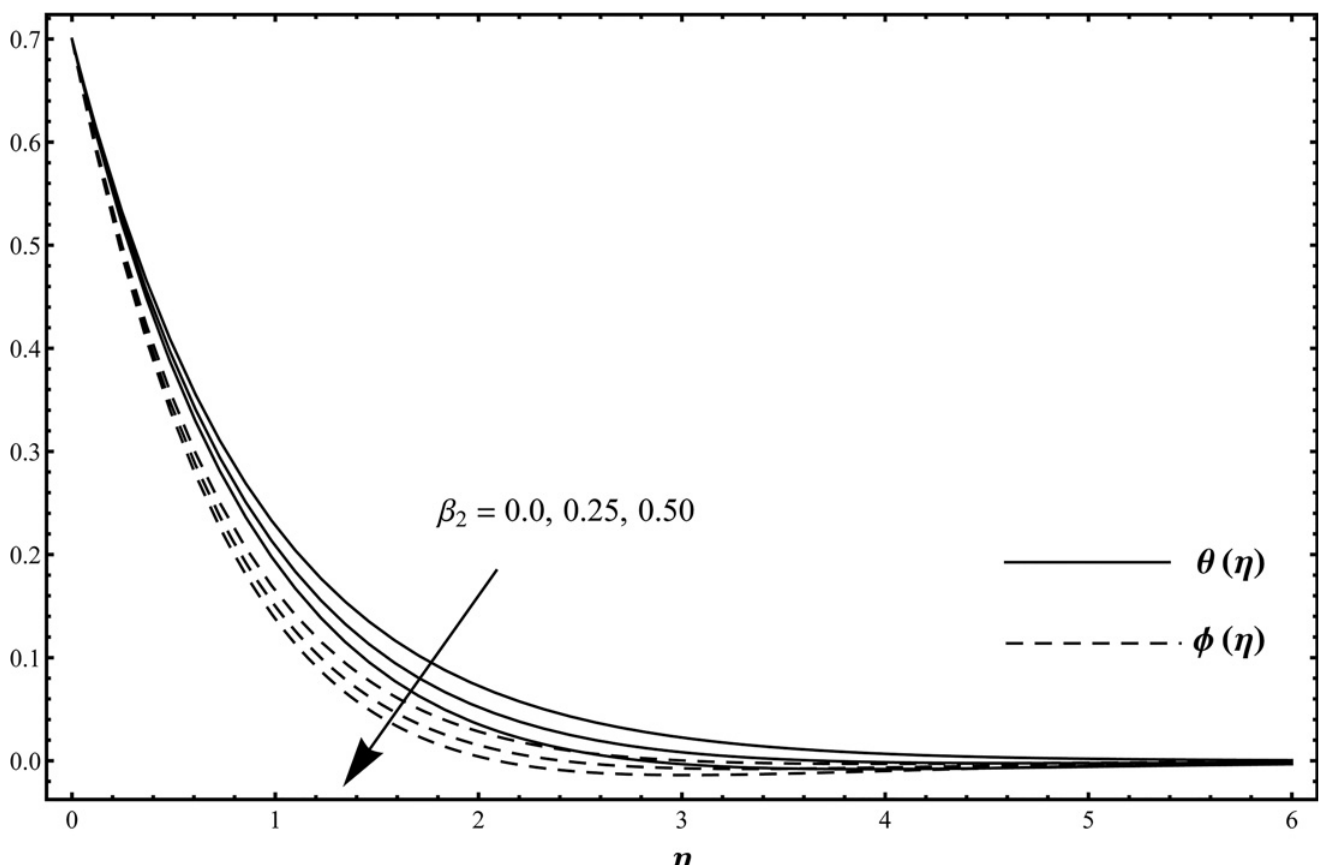
Fig 3. Temperature distribution function θ ( η ) and concentration distribution function ϕ ( η ) when β 2 = 0.0, 0.25, 0.50 and β 1 = 0.2 = γ = Rd , λ = 0.1 = N , Pr = 1.0 = Sc , ε 1 = 0.3 = ε 2